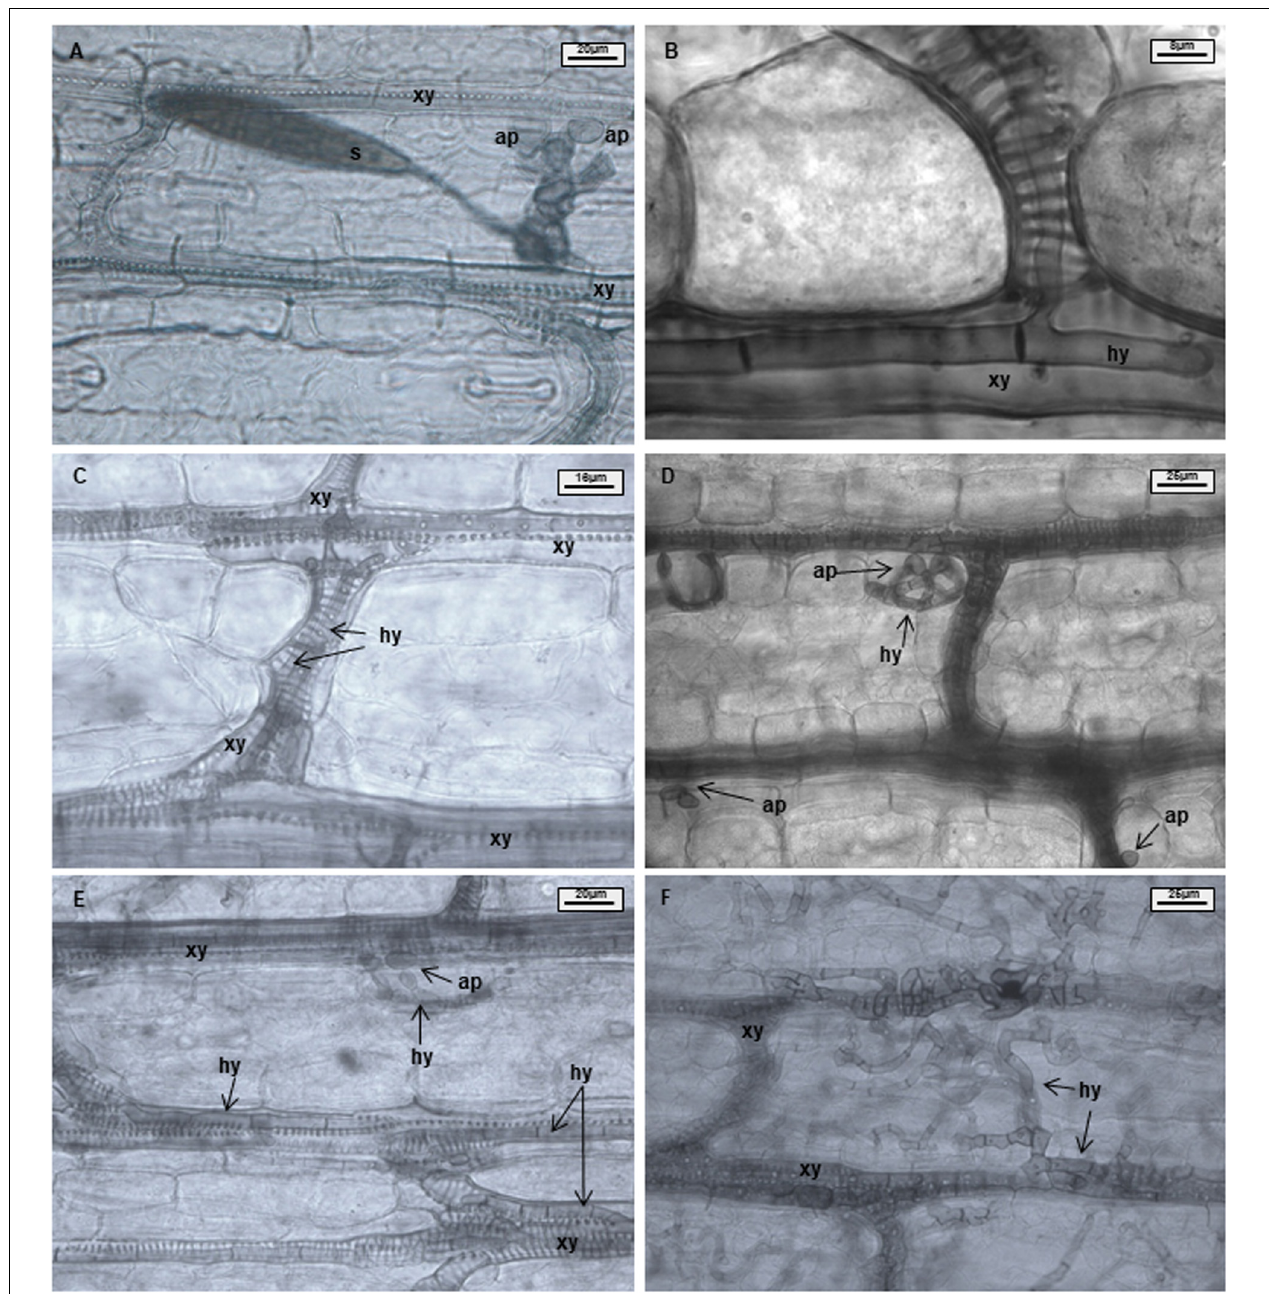
FIGURE 1 | Maize leaves infected with Exserohilum turcicum after staining with Chlorazol Black E (CBE). Light microscopical images of the mesophyll. Appressorium-like structures formed from hyphae in the mesophyll; hyphae originating from a germinated spore penetrate the epidermis and colonize the mesophyll (A) . One hypha colonizing a xylem vessel (B) . Hyphae growing in a xylem vessel (C) . Mesophyll penetration/colonization takes place at a different location than initial penetration (D) . Appressorium-like structure formed from hyphae inside a xylem vessel (E) . Xylem vessels and mesophyll colonized by the fungus (F) . B37 Ht2 incompatible interaction at 6 days post inoculation (dpi) (A) , B37 at 6 dpi (B,C,E) , B37 at 12 dpi (D) , and B37 at 18 dpi (F) . Hyphae (hy), xylem (xy), appressoria (ap), and spore (s).